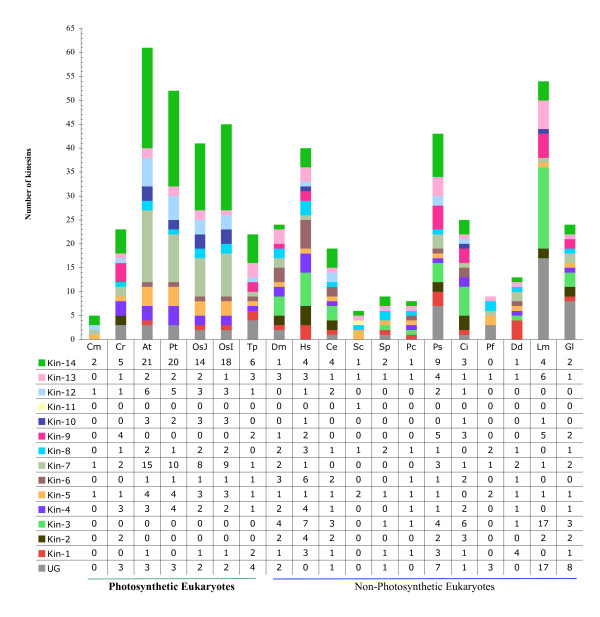
Number and distribution of kinesins. Tabular and graphical representation of the number of kinesins found in completely sequenced genomes used in our analysis. The number of kinesins is shown on the y-axis with the 19 species displayed across the x-axis. Different colors represent the distribution of kinesins into specific families. The data table below the chart details the specific number of kinesins in each family per species. For individual sequence IDs, please see Tables 2 through 7 and Additional files 1 through 12. Cm, Cyanidoschyzon merolae; Cr, Chlamydomonas reinhardtii; At, Arabidopsis thaliana; Pt, Populus trichocarpa; OsJ, Oryza sativa ssp. Japonica; OsI, Oryza sativa ssp. Indica; Tp, Thallassiosira pseudonana; Dm, Drosophila melanogaster; Hs, Homo sapiens; Ce, Caenorhabditis elegans; Sc, Saccharomyces cerevisiae; Sp, Schizosaccharomyces pombe; pc, Phaenerochaete chryosporium; Ps, Phytopthora sojae, Ci, Ciona intestinalis; Pf; Plasmodiumfalciparum; Dd, Dictyostelium discoideum; Lm, Leishmania major; Gl, Giardia lamblia.